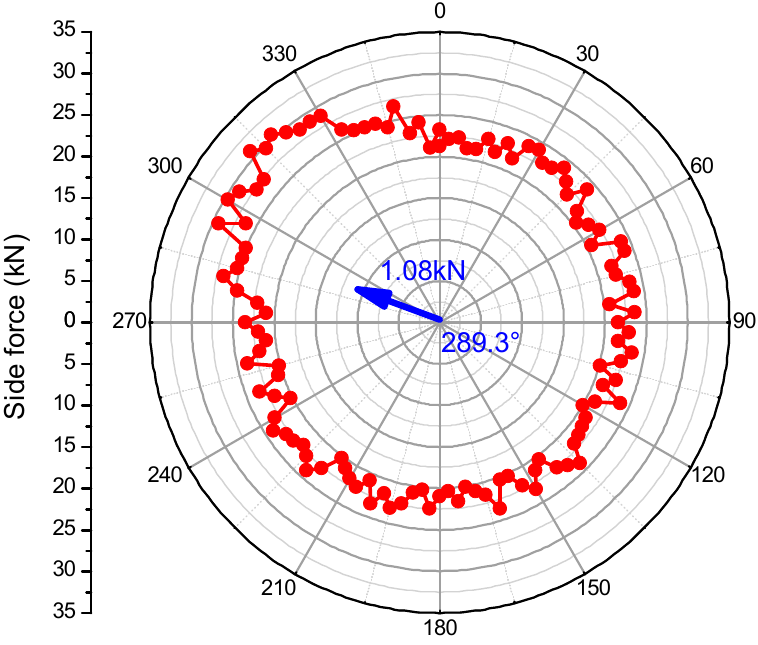
Figure 11. Side force on bit distribution in one round for drilling in well B.